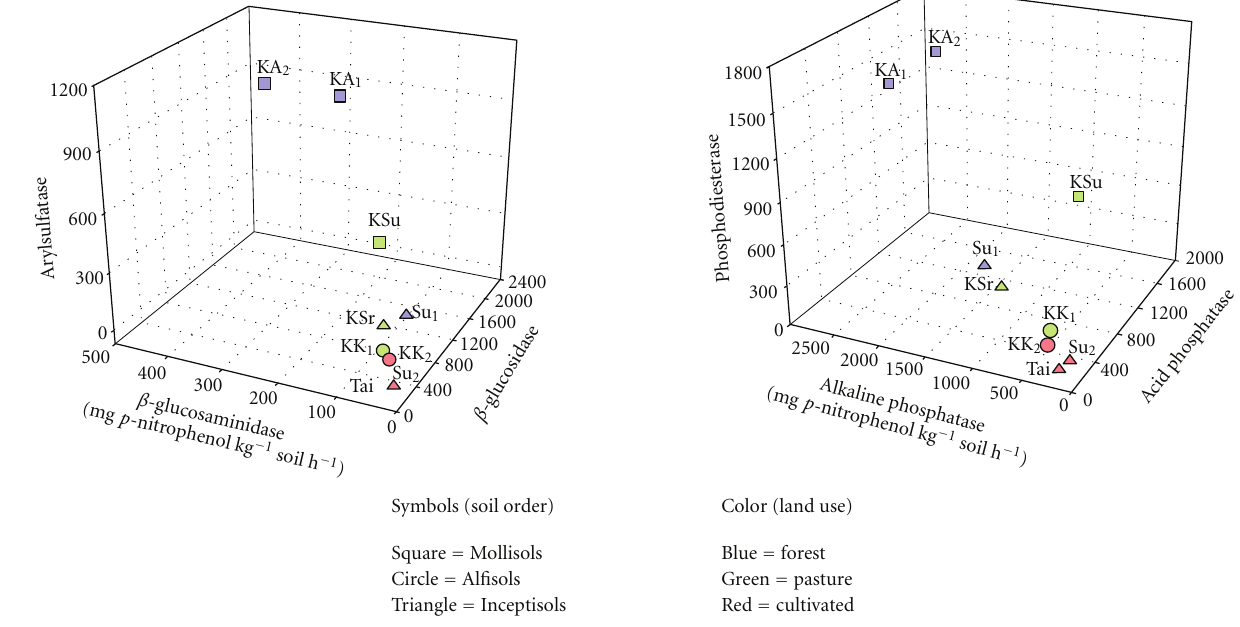
Figure 3: Three-dimensional plots showing three enzyme activities at a time under forest (blue), pasture (green), and cultivated (red). Soils were grouped according to taxonomy and are distinguished by squares (soils under Black-brown and Meadow-steppe or Mollisols), circles represent Brown soil (Alfisols) and triangles represent Sierozems (Inceptisols). The first two depths were summed for forest sites (Su 1 , KA 1 , and KA 2 ) and for two of the pasture sites (KSr, KK 1 ). The third pasture site is abbreviated KSu. The cultivated sites are abbreviated (Su 2 , Tai, and KK 2 . Details regarding the sites are described in Table